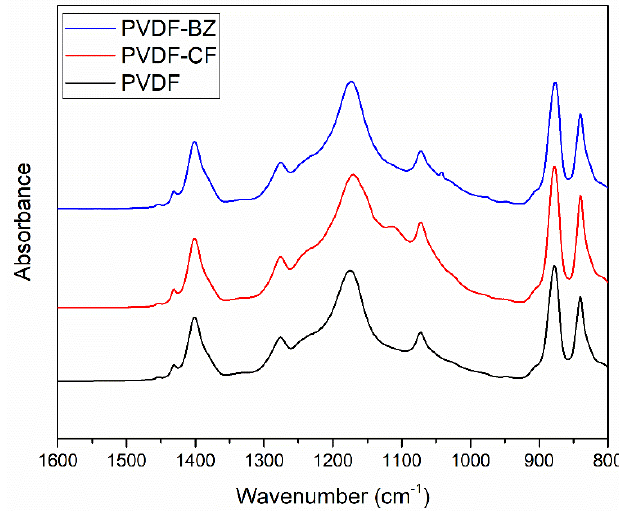
Figure 4. ATR-FTIR spectra of unmodified PVDF and modified membrane, PVDF-CF and